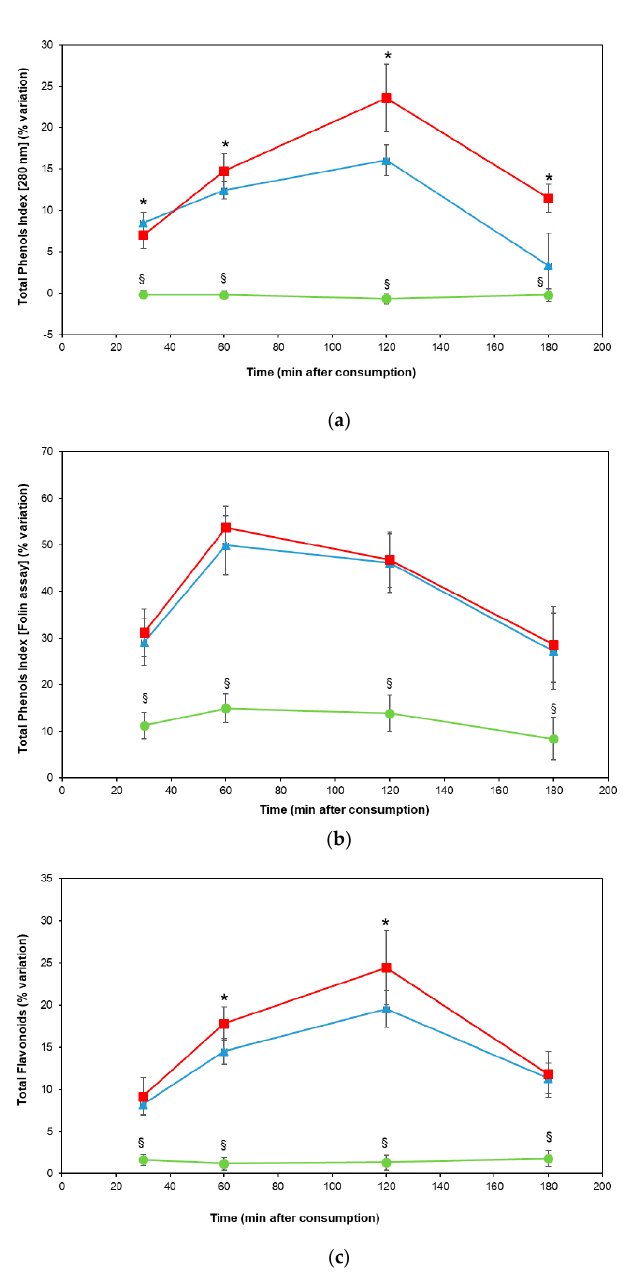
Figure 2. ( a ) Percentage variation (mean ± standard error) in the plasma total phenol index (spectrophotometric assay, absorbance reading at 280 nm) of volunteers (N = 19) 30, 60, 120 and 180 min after consuming 100 g of Venere (square), Artemide (triangle) or Carnaroli (circle) rice. The symbol (§) indicates statistically significant di ff erences between Carnaroli rice and the pigmented varieties ( p < 0.01); the symbol (*) indicates statistically significant di ff erences between Venere and Artemide rice ( p < 0.05); ( b ) percentage variation (mean ± standard error) in the total polyphenol plasma levels (Folin–Ciocalteu colorimetric assay, absorbance reading at 765) of volunteers (N = 19) 30, 60, 120 and 180 min after consuming 100 g of Venere (square), Artemide (triangle) or Carnaroli (circle) rice. The symbol (§) indicates statistically significant di ff erences between Carnaroli rice and the pigmented varieties ( p < 0.01); (c) percentage variation (mean ± standard error) in the total flavonoid plasma levels (spectrophotometric assay) of volunteers (N = 19) 30, 60, 120 and 180 min after consuming 100 g of Venere (square), Artemide (triangle) or Carnaroli (circle) rice. The symbol (§) indicates statistically significant di ff erences between Carnaroli rice and the pigmented varieties ( p < 0.01); the symbol (*) indicates statistically significant di ff erences between Venere and Artemide rice ( p <